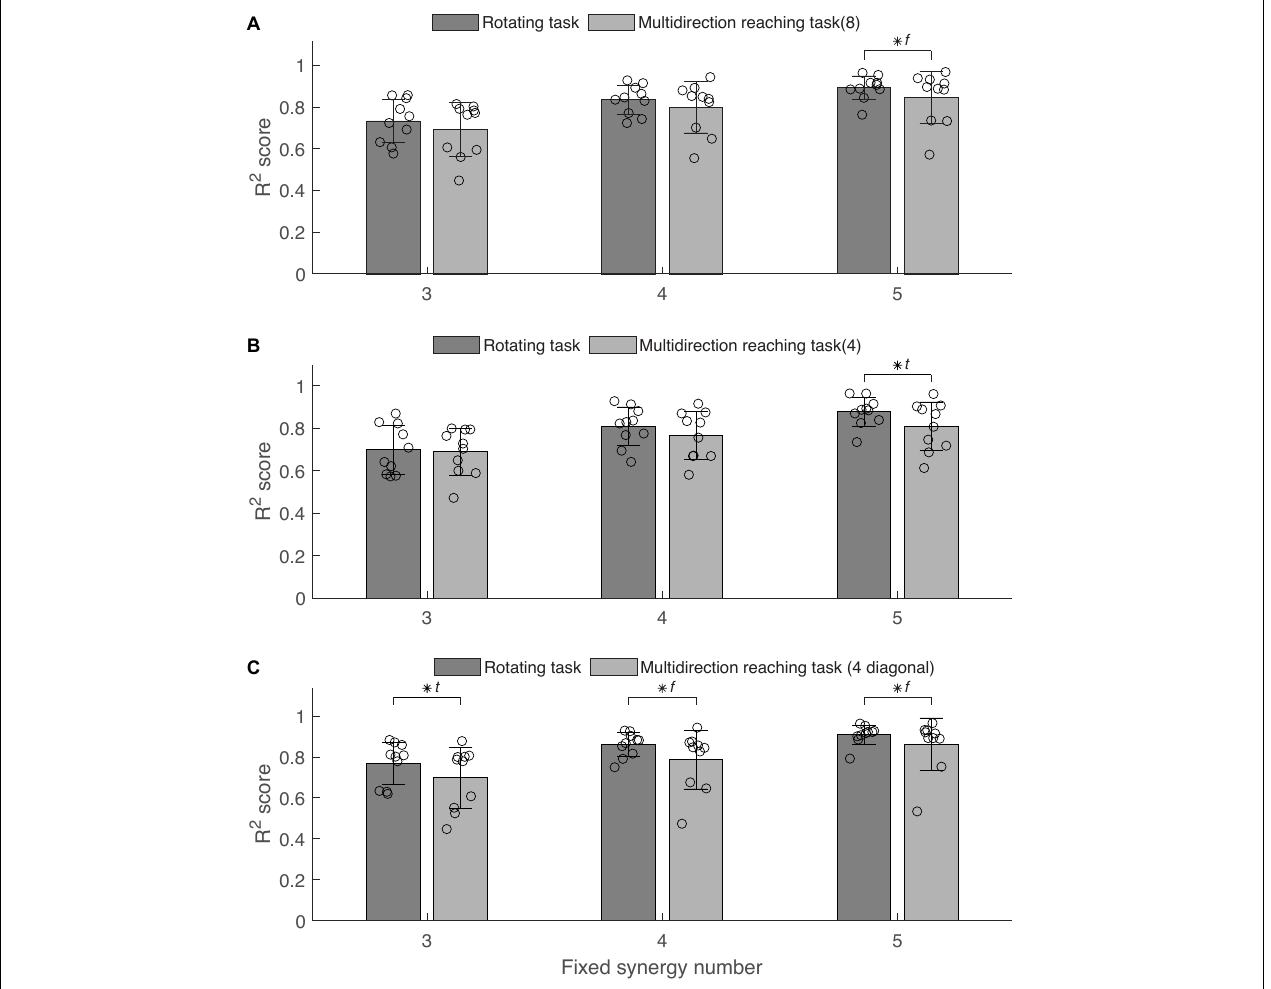
FIGURE 7 | Electromyography reconstruction R 2 score between the rotating task and multidirection reaching conditions. Error bars indicate the standard deviation. Scattered circles indicate R 2 score of each subject in each condition. Asterisk indicates statistical significance in the t -test and f -test. (A) Comparison between rotating task and multidirection reaching task (8 directions: condition 2). (B) Comparison between rotating task and multidirection reaching task with 4 targets (condition 3). (C) Comparison between rotating task and multidirection reaching task with 4 diagonal targets (condition